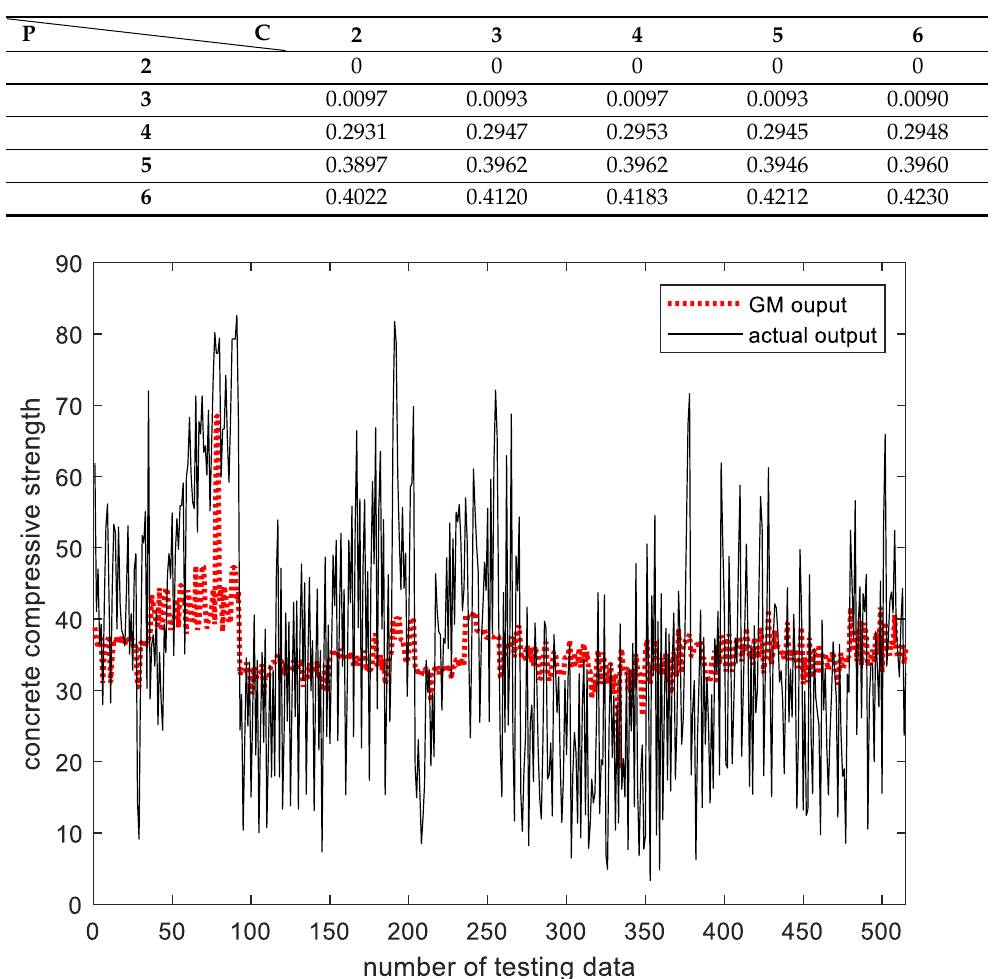
Table 2. Performance index of GM that created context flexibly.